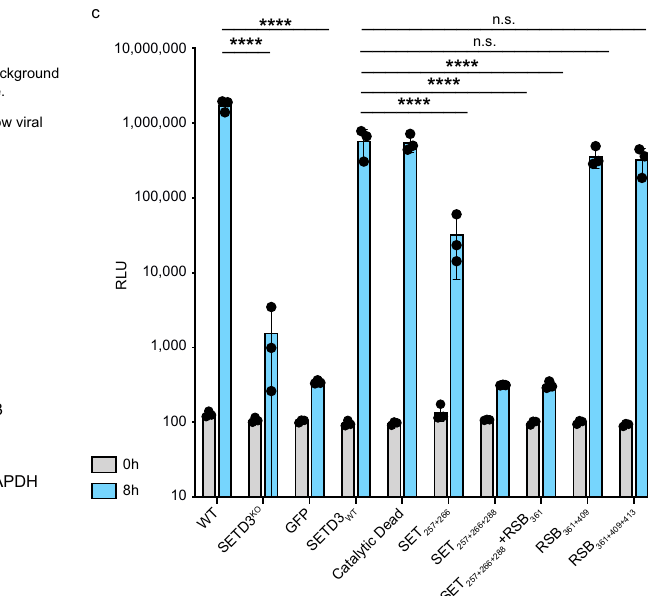
independent samples were measured for one independent experiment. Data are presented as mean and standard deviation. Source data are provided as a Source Data fi le. Statistics were performed on 8h timepoints using GraphPad Prism 9 (Version 9.3.1). P- values were determined by two-way ANOVA (Holm – Sidak cor- rected) on log-transformed data. RLU relative light units, n.s. not signi fi cant, **** P ≤